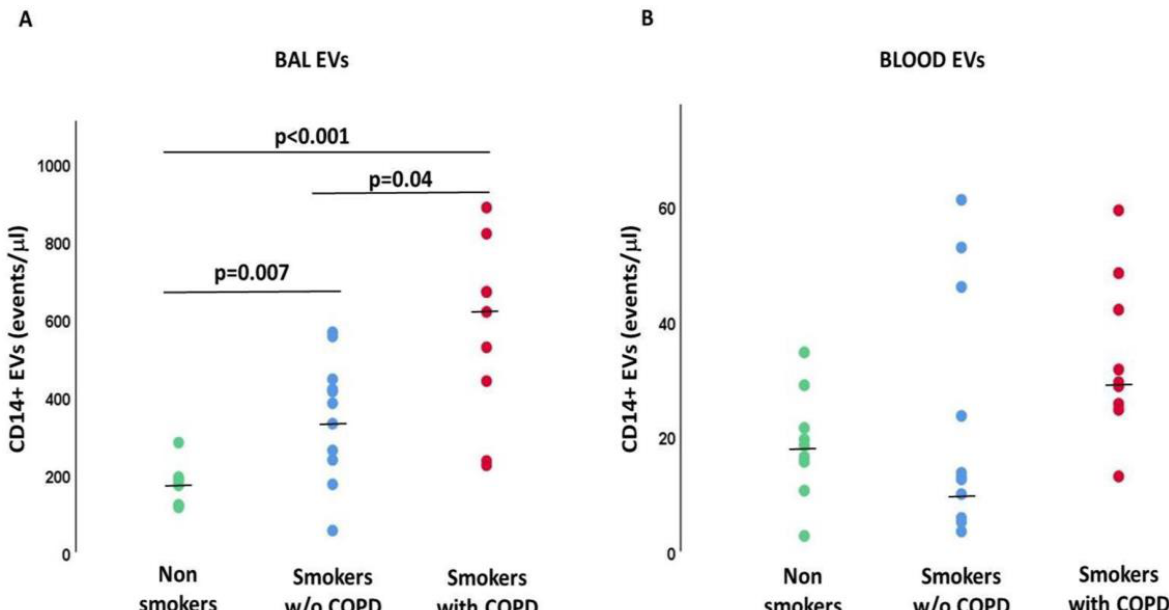
Figure 1. Macrophage-derived EVs (CD14+ events/μ L) in BAL ( A ) and Blood ( B ). p values in the figure represent the results of Mann-Whitney U tests. Kruskal-Wallis test: p < 0.001 for BAL EVs. Kruskal-Wallis test: p = NS for Blood EVs. The number of EVs/ µ L derived from BAL epithelial cells (CD326+) was significantly higher in smokers with ( p < 0.001) and without COPD ( p < 0.001) than in nonsmokers (Figure 2A). In contrast, the number of EVs/ µ L derived from plasma epithelial cells was not significantly different between the three groups of subjects (Figure 2B).